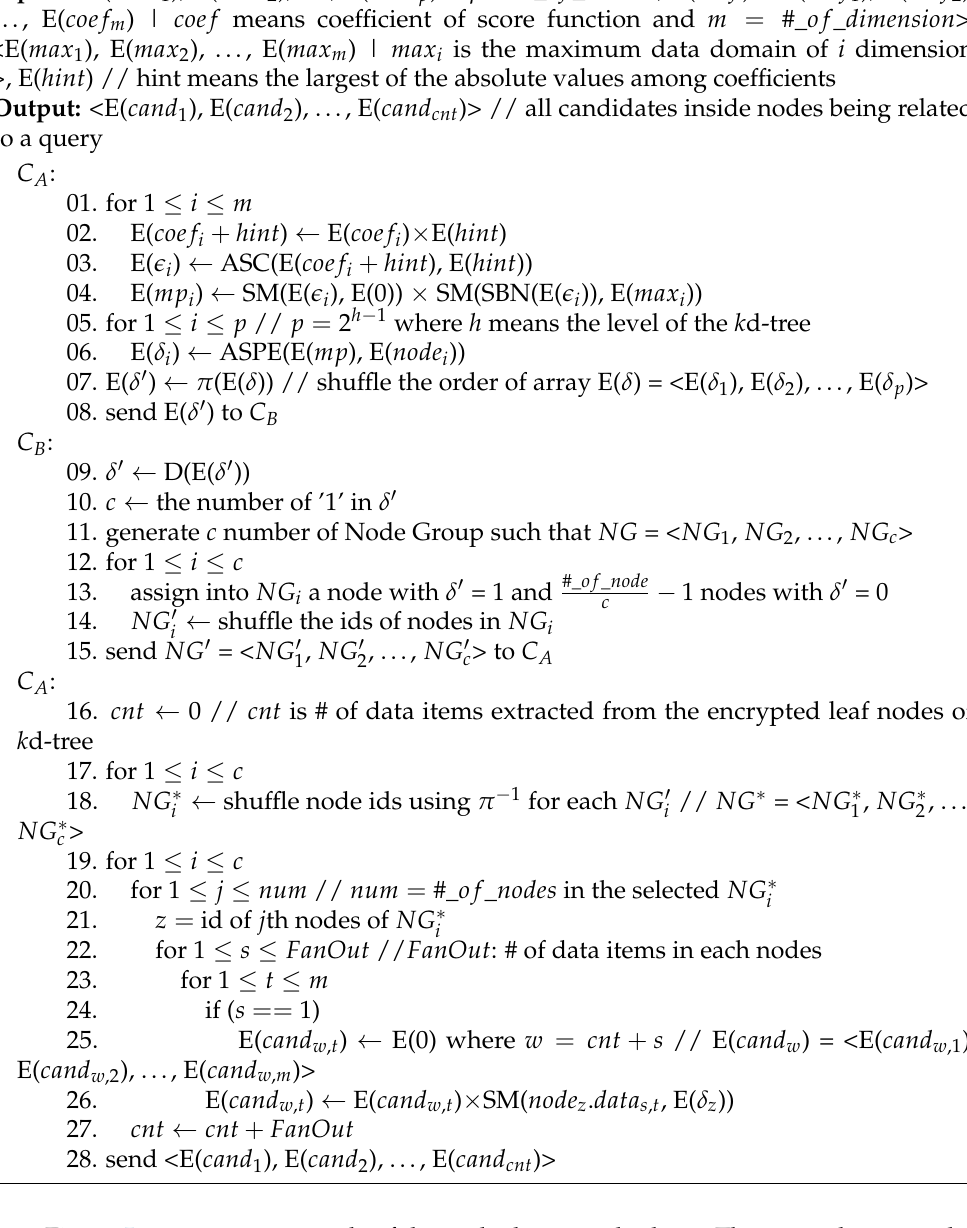
Algorithm 4 Node data search